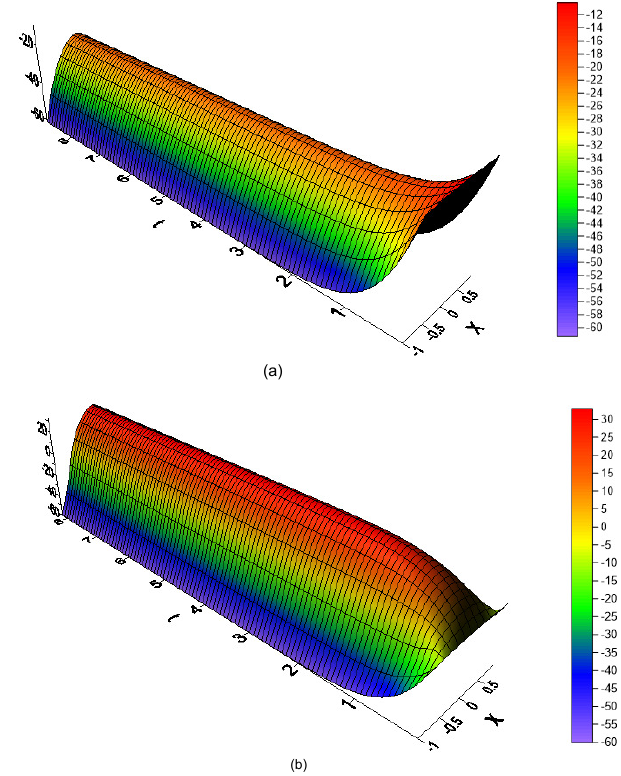
Figure 6. Evolution towards the stationary solution taking as solar constant Q = 300 taking an initial condition u ( x ,0 ) < − 10 ◦ C ( a ) and u ( x ,0 ) > − 10 ◦ C ( b